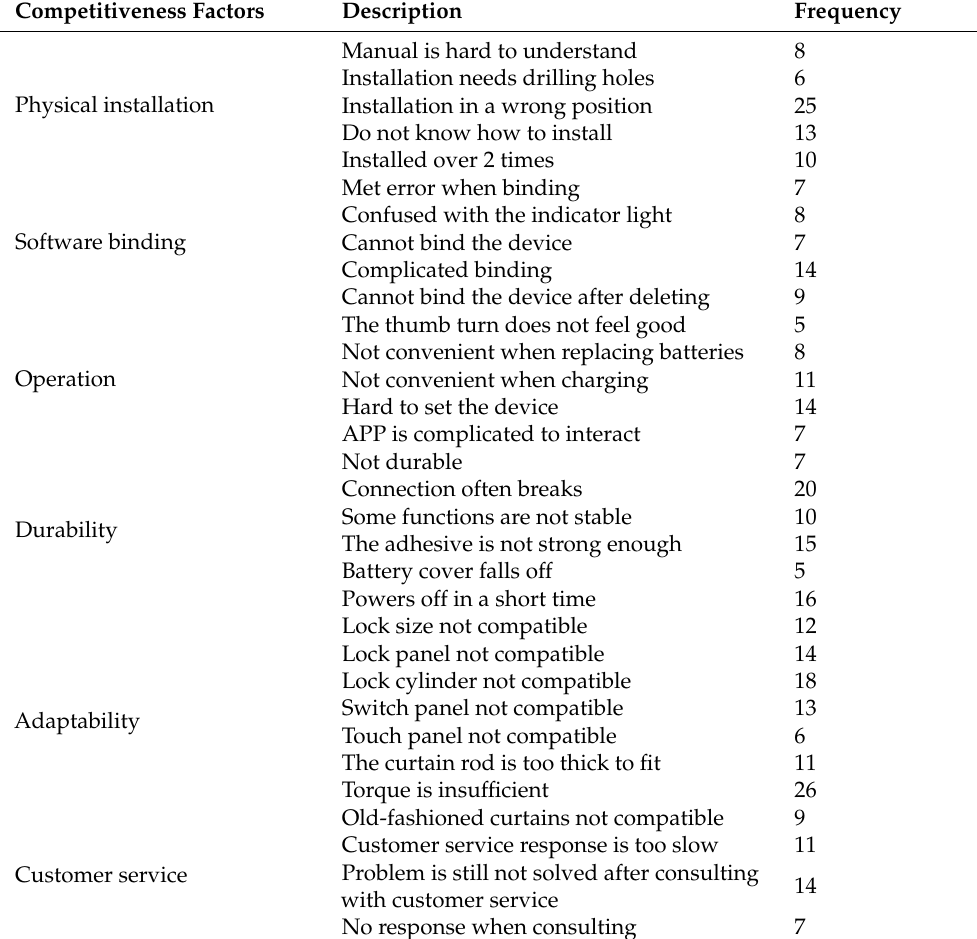
Table 2. Online reviews derived from GED